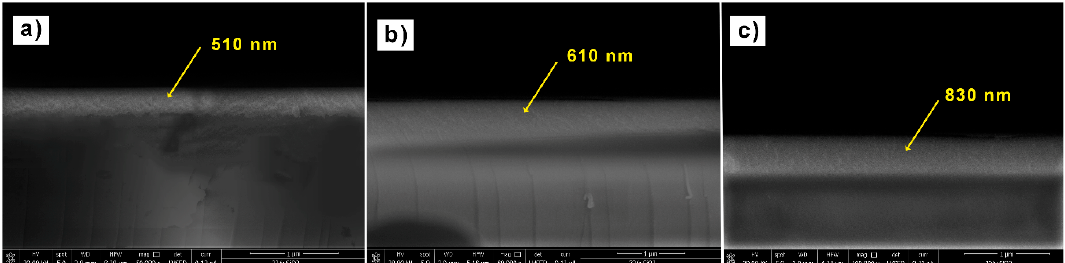
Figure 3. SEM micrographs of SiO 2 films profiles on Si substrates: ( a ) Sample P1, ( b ) sample P2, ( c ) sample P3.